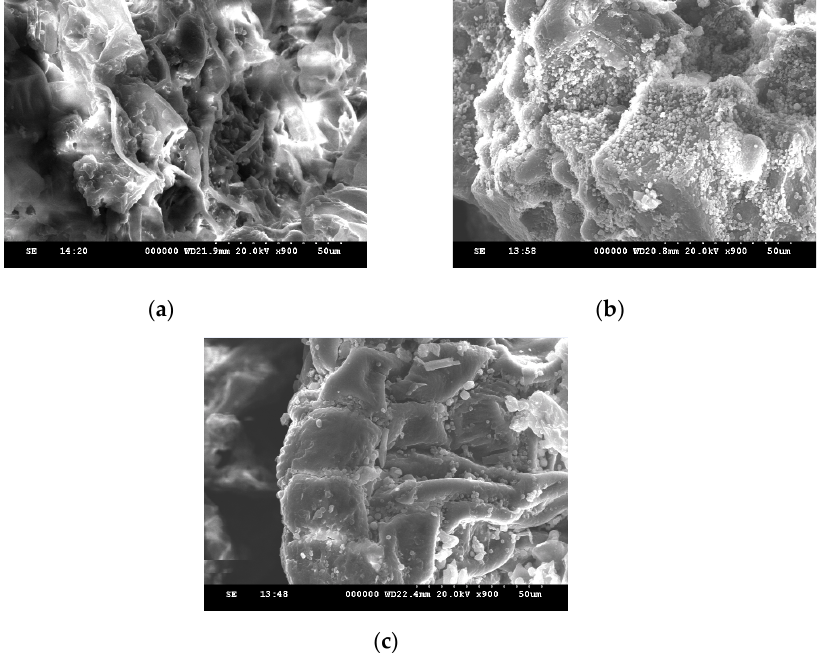
Figure 2. Scanning electron micrographs of Chenopodium formosanum samples extracted with ( a ) no solvent, ( b ) 100% water, and ( c ) 100% ethanol.